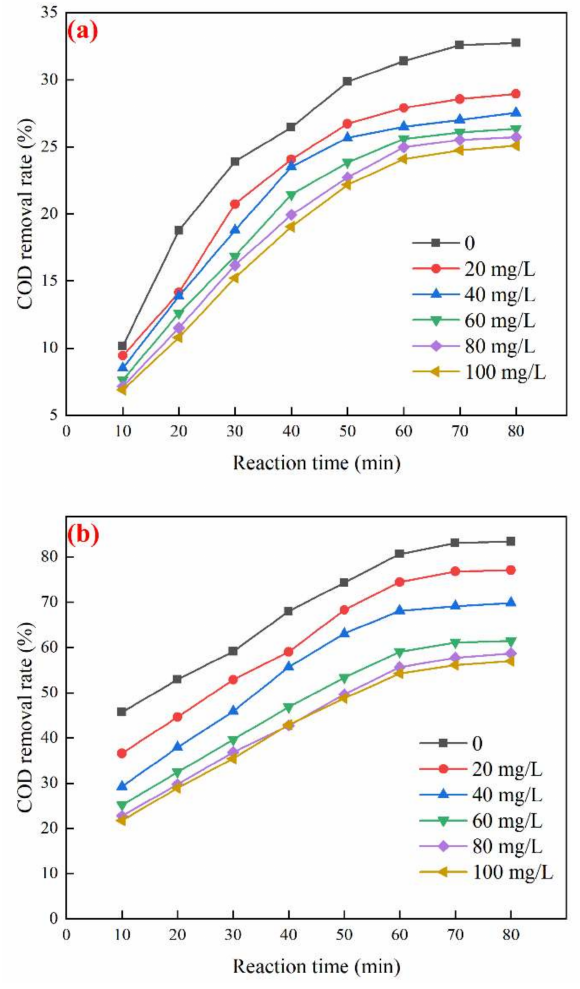
Figure 6. Effect of TBA dosage on COD removal rate: ( a ) ozonation alone, ( b ) catalytic